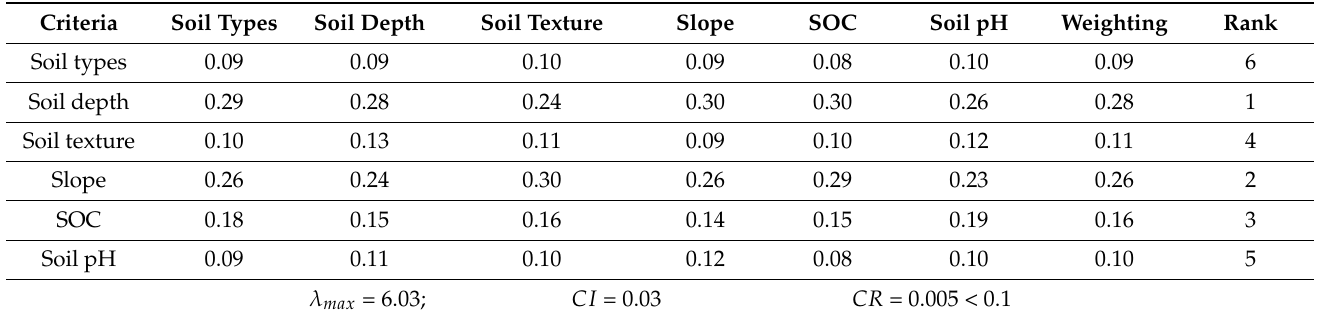
Table 6. The pairwise comparison matrix and criteria weight by AHP method.